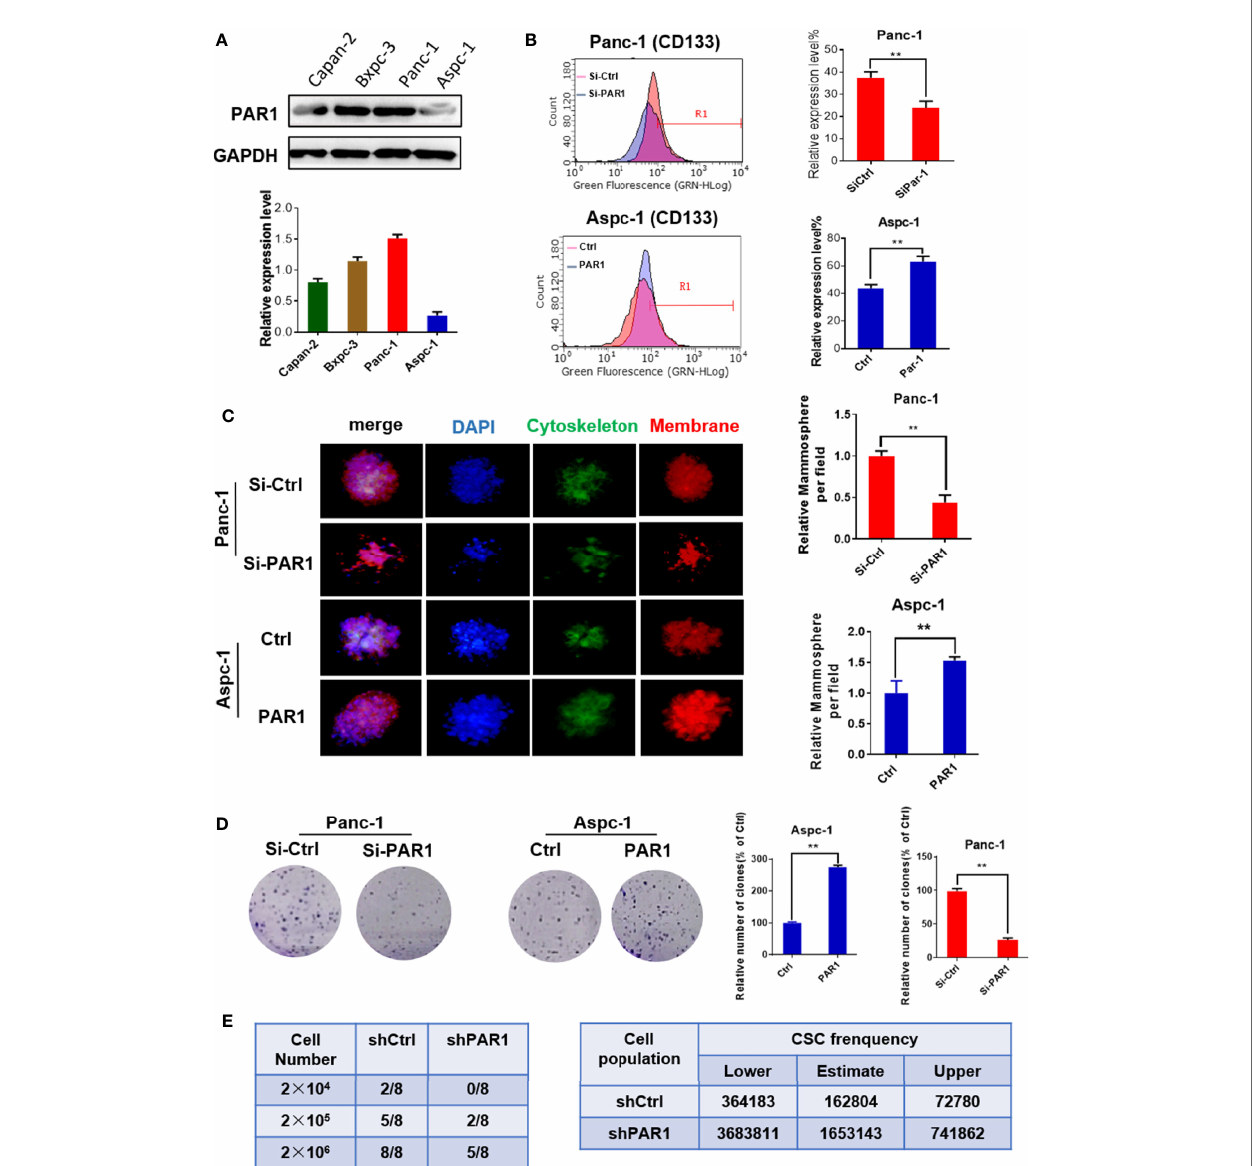
FIGURE 1 | PAR1 promotes the cancer stem cell-like properties of pancreatic cancer cells. (A) The expression levels of PAR1 in Panc-1, Bxpc-3, and Aspc-1 cell lines were detected by Western blot analysis. (B) Effect of PAR1 on pancreatic cancer stem cell markers CD133 in Panc-1 and Aspc-1 cells. (C) Effect of PAR1 on the mammosphere-forming potential of pancreatic cancer cells in PAR1 over-expression and interference experiments. (D) Effect of PAR1 on clone formation of Panc-1 and Aspc-1 cells. (E) Effect of PAR1 on the tumorigenicity of Panc-1 cells and PAR1 knockdown Panc-1 cells by using limiting dilution assay in node mice ( n = 8). Cancer stem cell frequency was determined by ELDA (http://bioinf.wehi.edu.au/software/elda). Data are shown as the mean ± SD (** P <